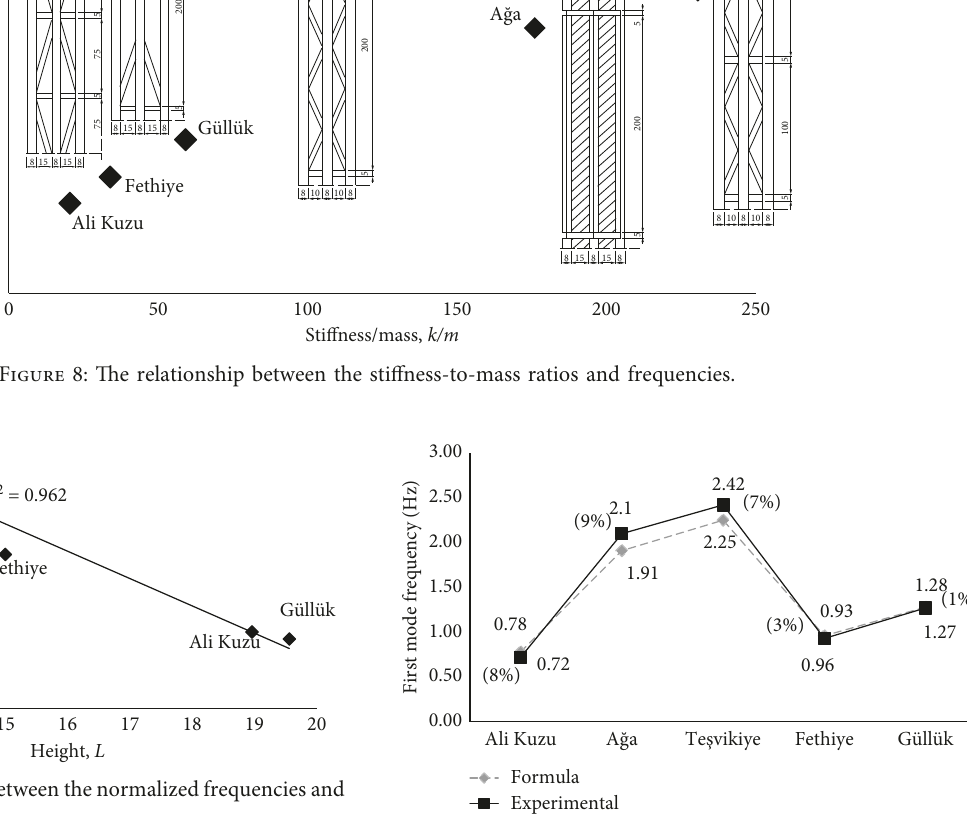
Figure 11: The fundamental frequencies (formula versus experi- mental